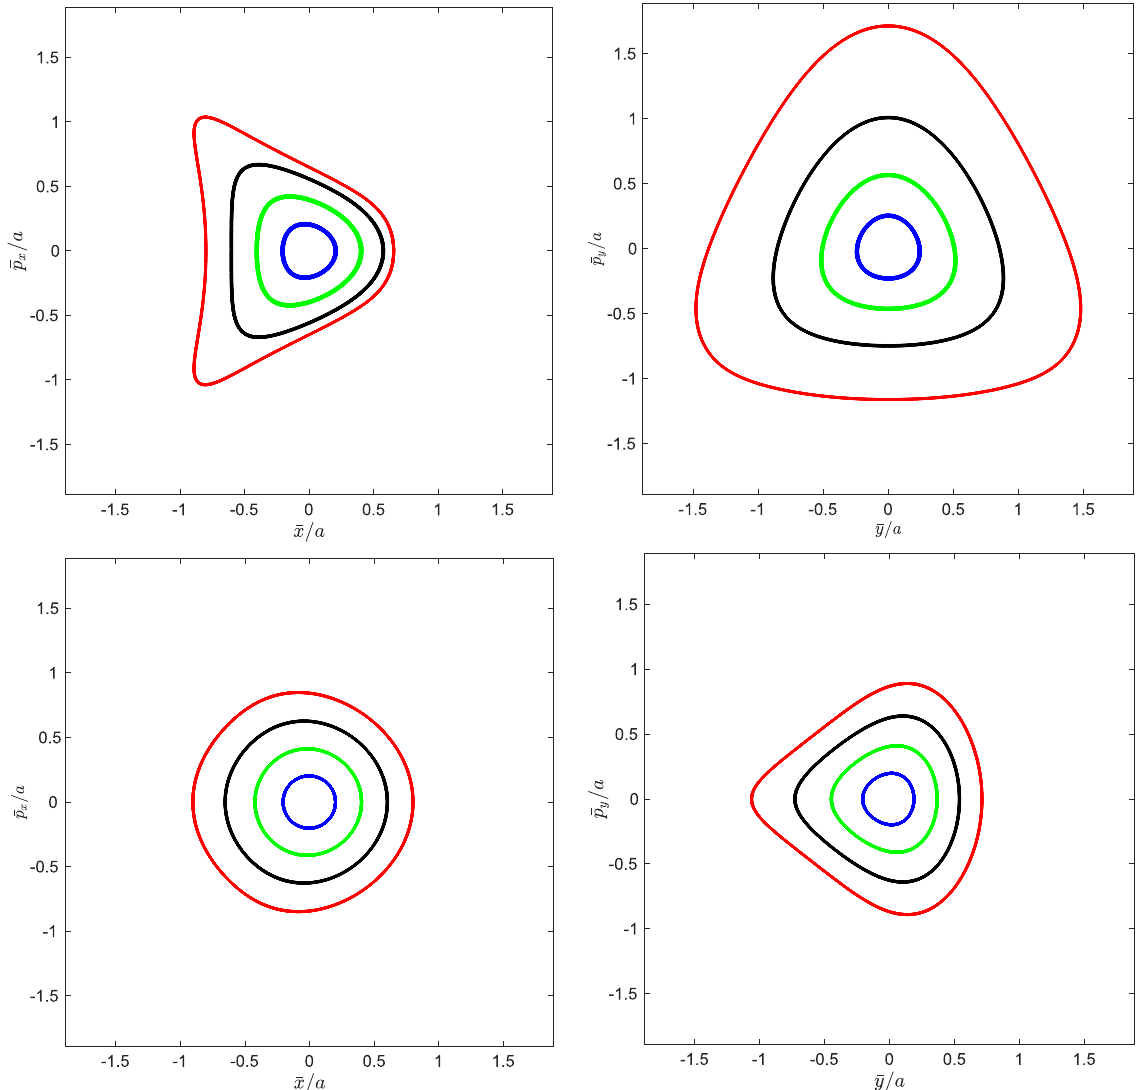
FIG. 15. Two sets of quasi-invariant tori in the normalized 4D phase spaces at the betatron tune: ν ¼ 0 . 28 . The dots represent the orbits from tracking with cell length L ¼ 15 m and angle ϕ ¼ π = 96